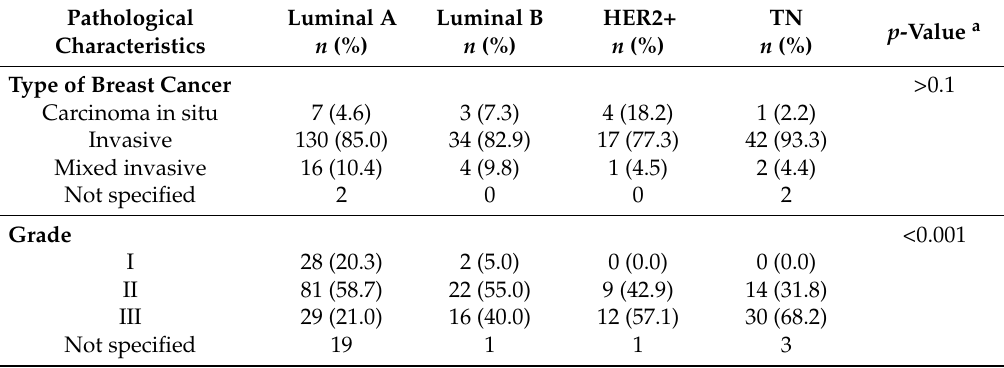
Table 2. Pathological characteristics of tumors by breast cancer molecular subtype.